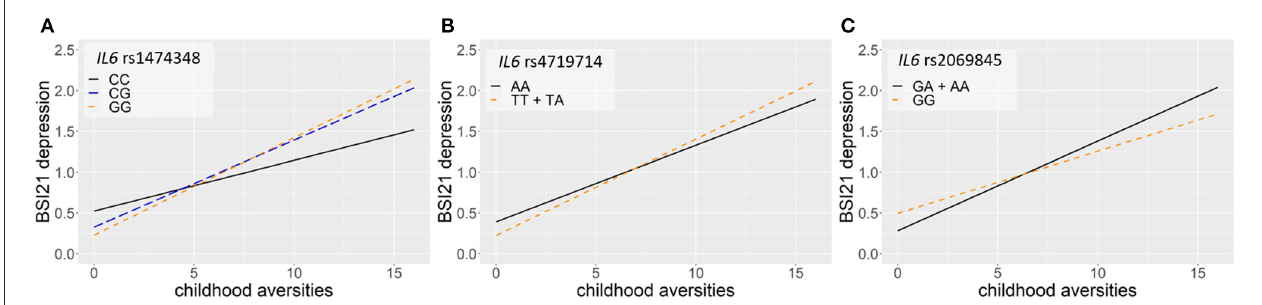
FIGURE 4 | Linear regression models on the interaction between IL6 and childhood adversities on current thoughts of death (ToD-BSI21) yielded three significant clumps. In case of the additive model, a clump containing 24 SNPs with rs1474348 as top SNP and the minor C allele as a protective allele emerged ( p = 0.0005) (A) . In case of the dominant model, a clump containing 5 SNPs with top SNP rs4719714 and the minor T allele as a risk allele was found ( p = 0.0007) (B) . In the recessive model, a clump containing 19 SNPs with rs2069845 as top SNP and the minor G allele as a protective allele was identified ( p = 0.0002) (C) . The figure was generated for illustration purposes using R.